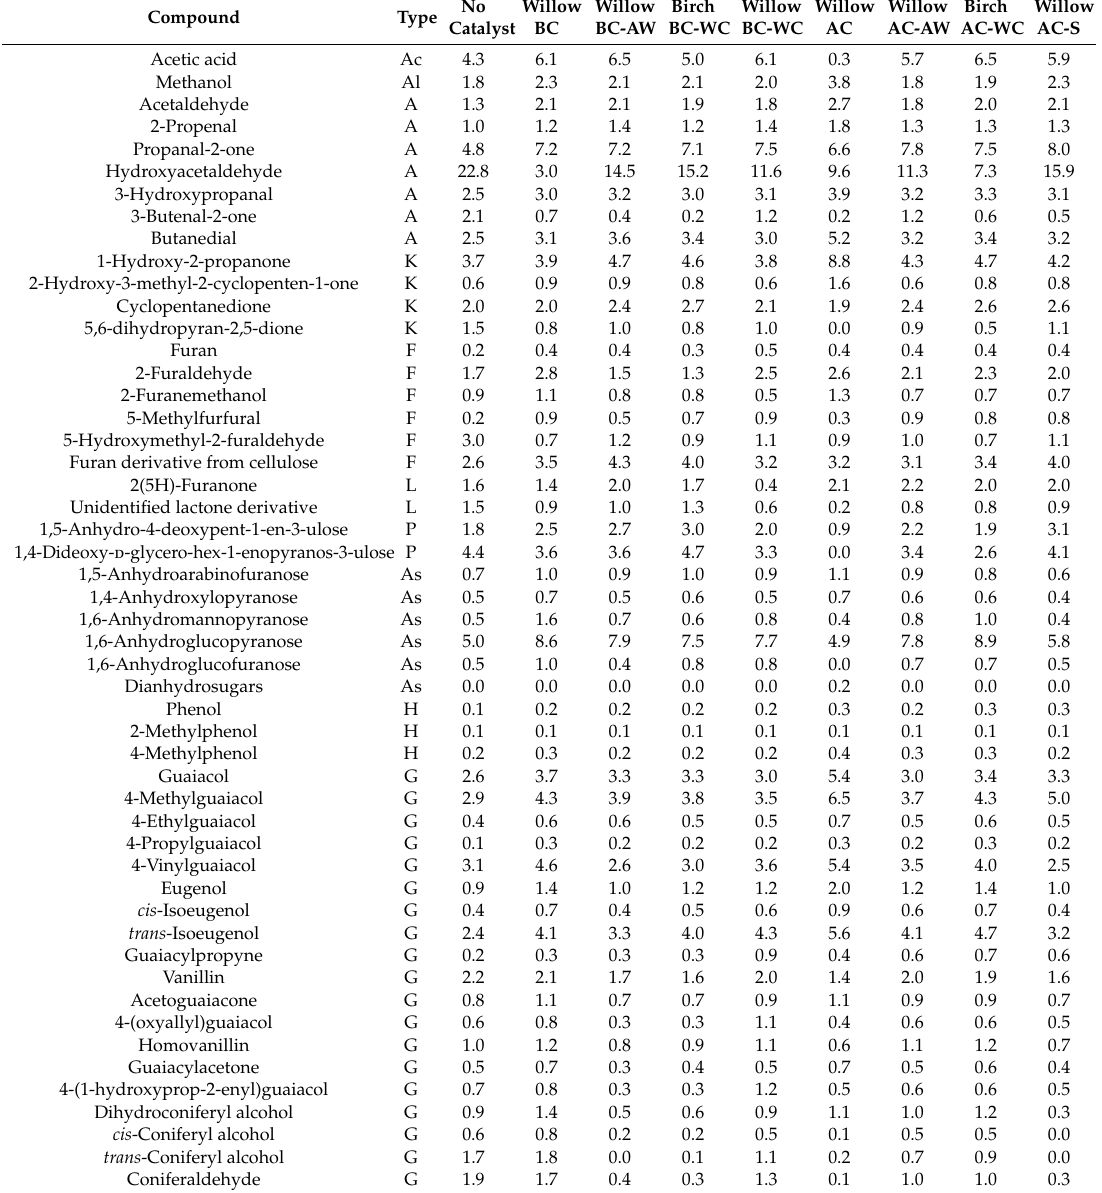
Table A1. Lignin and polysaccharide derivatives (peak areas normalized to 100%) formed in pyrolysis of